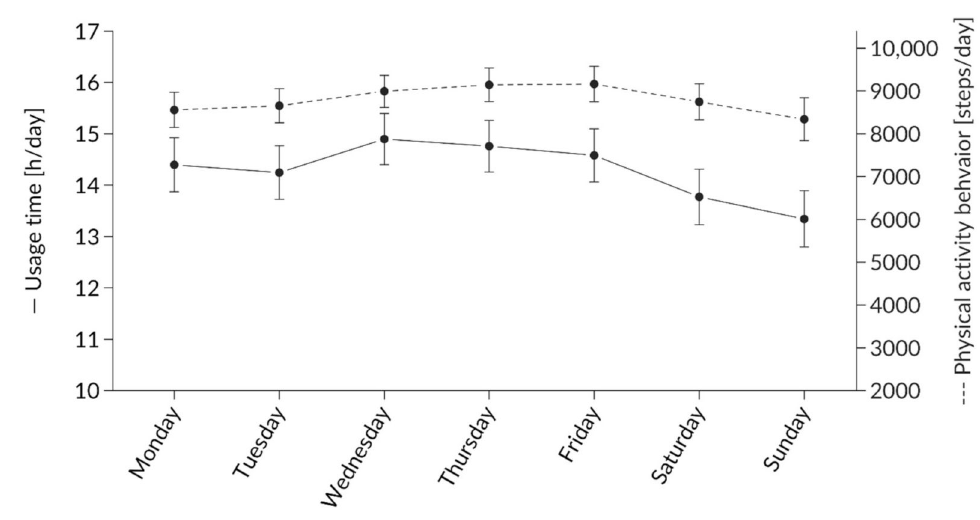
Figure 3. Average use per day of the week.